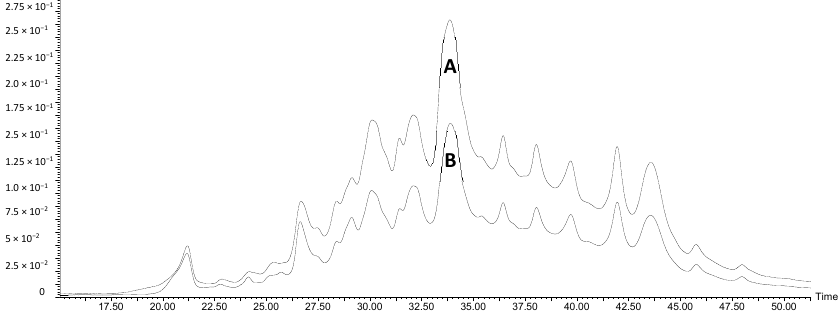
Figure 1. Chromatograms at 280 nm of MW RW ( A ) and RW ( B ), as obtained by HPLC.